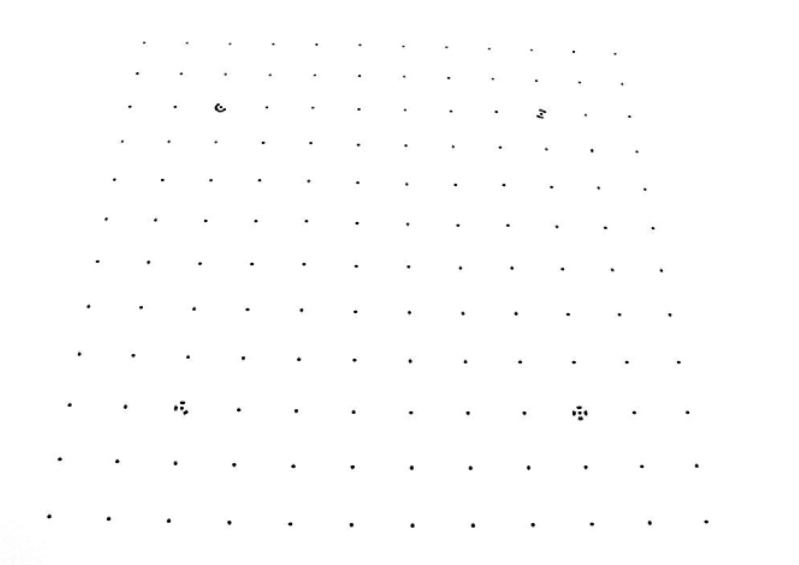
Photograph 2. Plane point field used during calibration of the